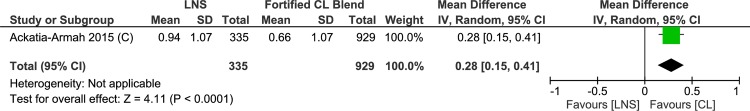
Forest plot: Lipid-based nutrient supplement versus Specially formulated micronutrient fortified foods, outcome: 1.17 Weight-for-length z-score Gain.